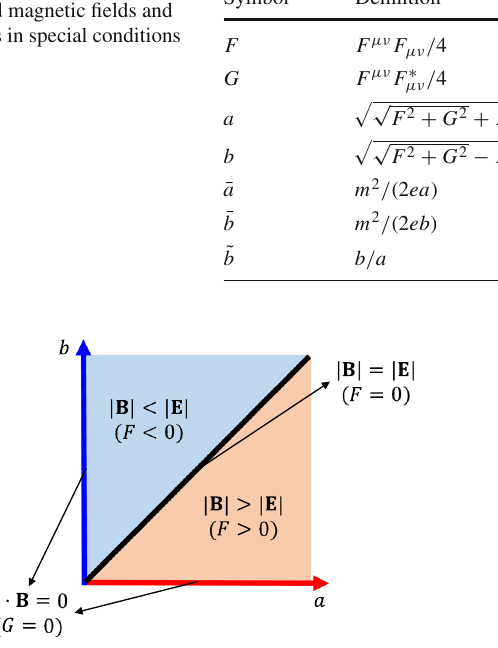
Fig. 1 Classificationofuniformelectromagneticfieldsinthe ab -plane. The diagonal line b = a corresponds to the condition of equally strong electric and magnetic fields, i.e., | B | = | E | ( F = Thehorizontalandverticalaxescorrespondtothewrenchlesscondition, i.e., G = − E · B =